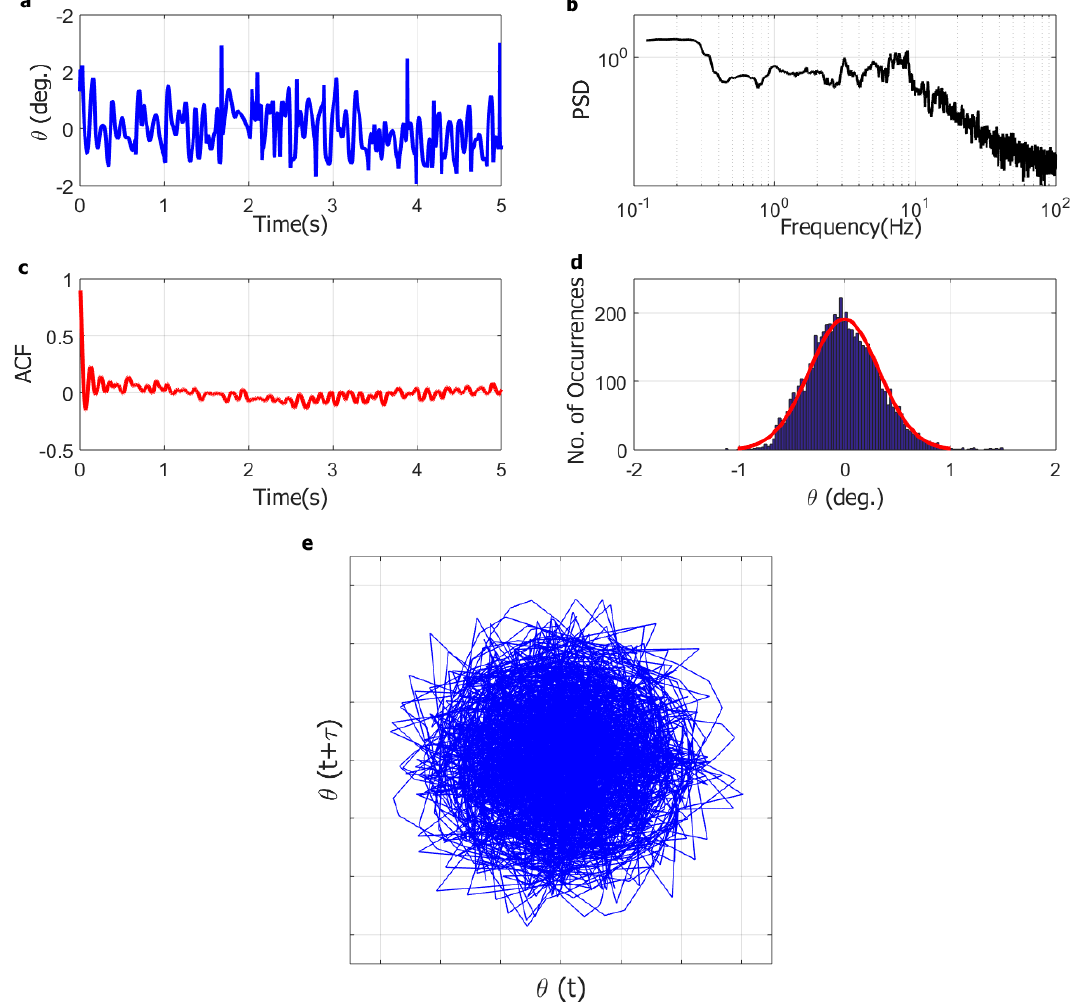
Figure 7. Representative dynamics of deflected regime for the full-solar flag at wind speed of 9.7 m / s: ( a ) angular position time series (5 s); ( b ) angular position power spectral density (PSD); ( c ) angular position autocorrelation function (ACF); ( d ) angular position histogram; ( e ) system trajectory in phase-space (reconstructed attractor).